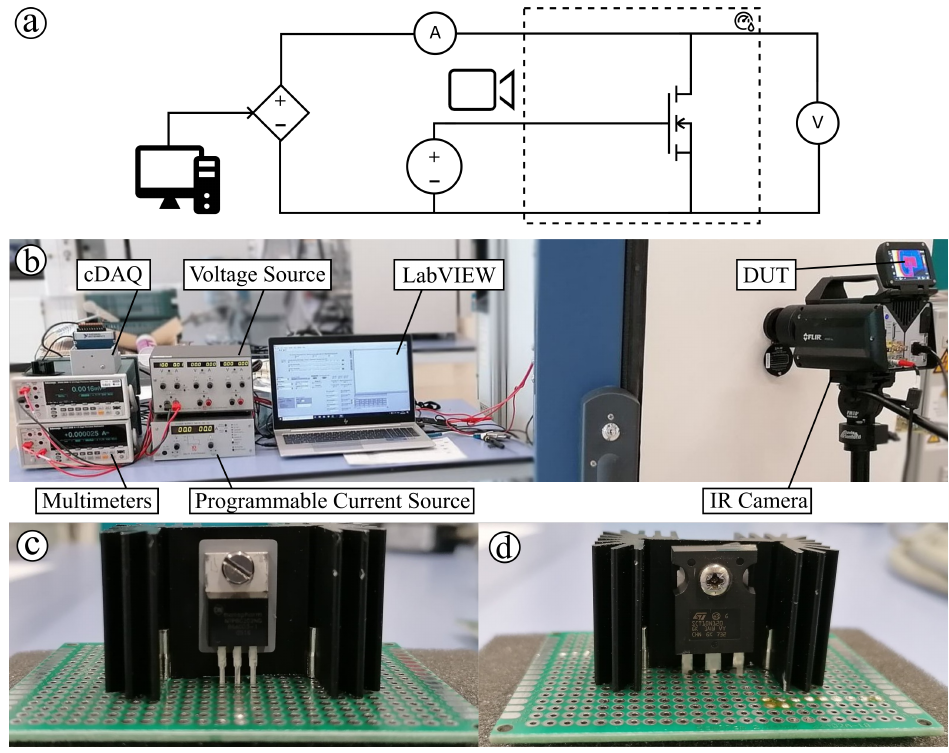
Figure 2. ( a ) The schematic and ( b ) photo of the experimental setup to validate the power losses model of the ( c ) cascode gallium nitride (GaNO) metal-oxide-semiconductor field-effect transistors (MOSFET) and the ( d ) silicon carbide (SiC) MOSFET.